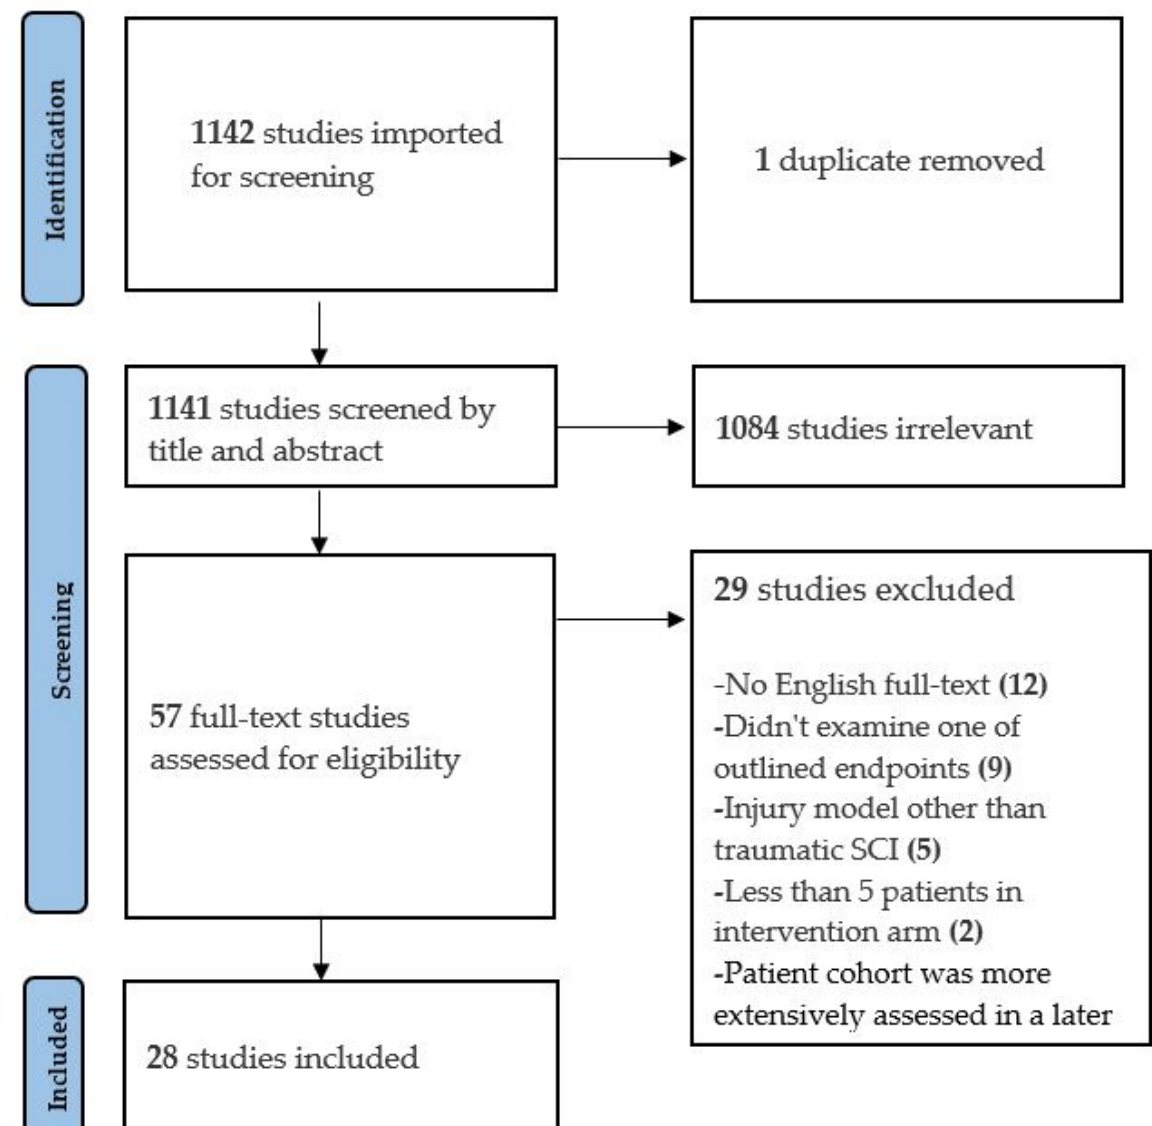
Figure 1. PRISMA flow diagram.